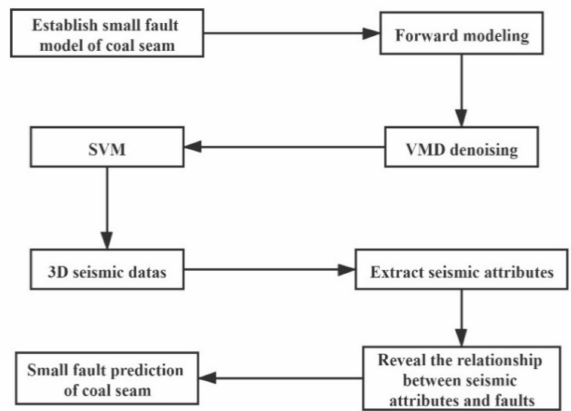
Figure 3. Flow chart of small fault prediction.